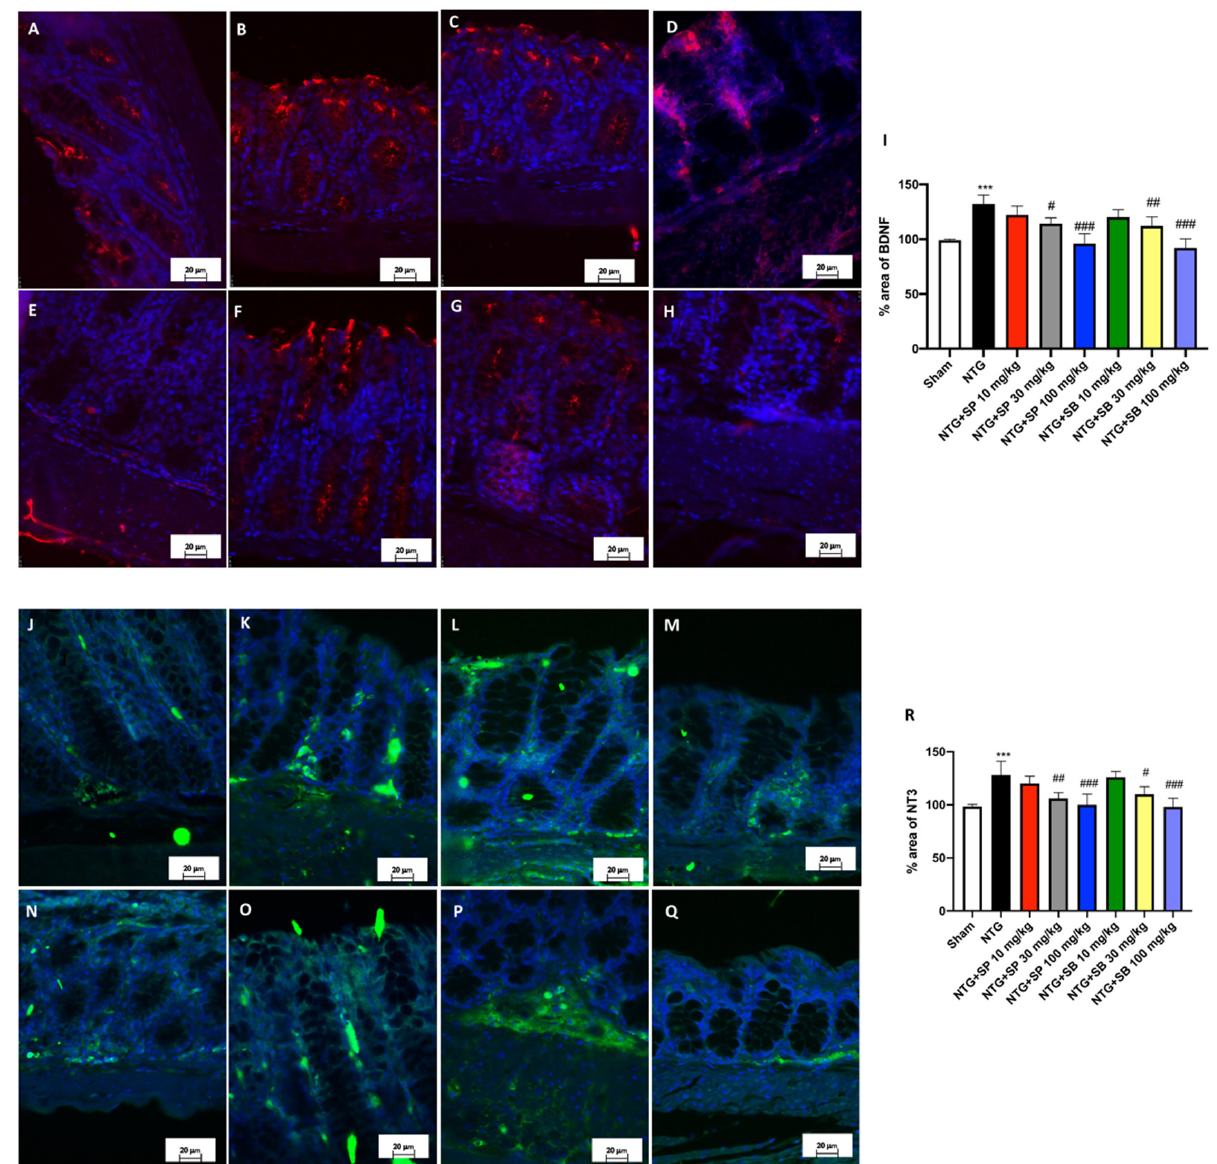
Figure 6. SCFA treatments decrease NT expression in the intestine following NTG injection. Positive NTs immunostaining is found in NTG-injected mice ( B , I ; K , R ) compared to the sham animals ( A , I ; J , R ). SCFAs of 30 mg/kg treatments ( D , G , M , P ), but most of all SCFAs of 100 mg/kg treatments ( E , N , H , Q ), reduce this positive staining. Mice treated with 10 mg/kg of SCFAs do not show any significant reduction in BDNF and NT expressions ( C , F , L , O ). Data are representative of at least three independent experiments; one-way ANOVA test. *** p < 0.001 vs. sham; # p < 0.05 vs. NTG; ## p < 0.01 vs. NTG; ### p < 0.001 vs. NTG. N = 10 mice/group for each